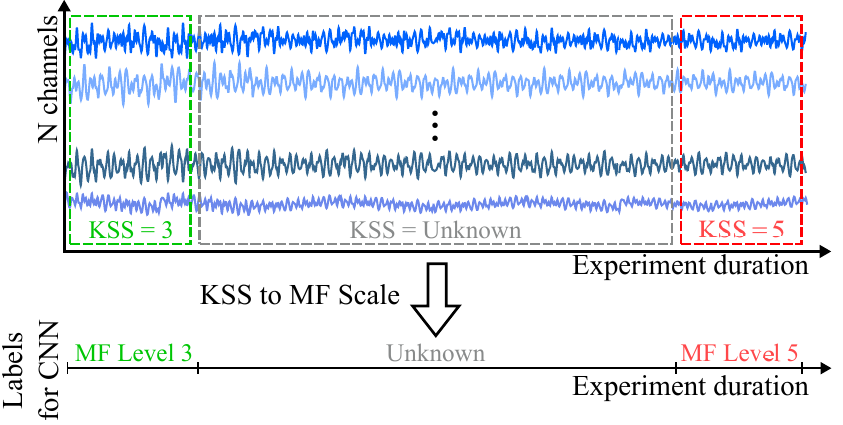
Figure 6. Labeling approach used to convert Karolisnka Sleepiness Scale (KSS) score to our proposed mental fatigue (MF) scale for CNN